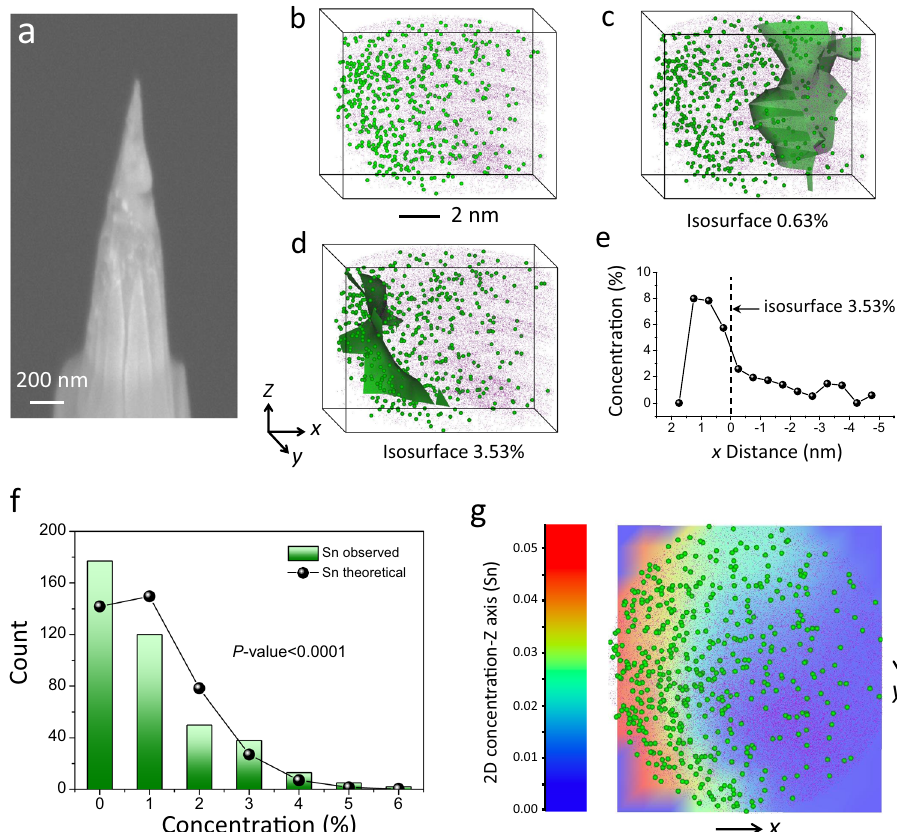
Fig. 2 Atom probe tomography. a SEM side view (54° tilted) of the needle-shape specimen. b 3D tomography of the Cu 97 Sn 3 nanoparticle demonstrates the position relationship of Sn dopants (green) and Cu matrix (purple). c Sn iso-surface of 0.63 wt.% indicates the low dopant concentration region on the Cu nanoparticle, in contrast to ( d ) the Sn-rich region evidenced by the 3.53 wt.% Sn iso-surface. The z -direction of tomography corresponds to the tip axial direction. e A proxigram pro fi le was in accordance with 3.53 wt.% Sn iso-surface, demonstrating the Sn composition reduces along the arrow direction